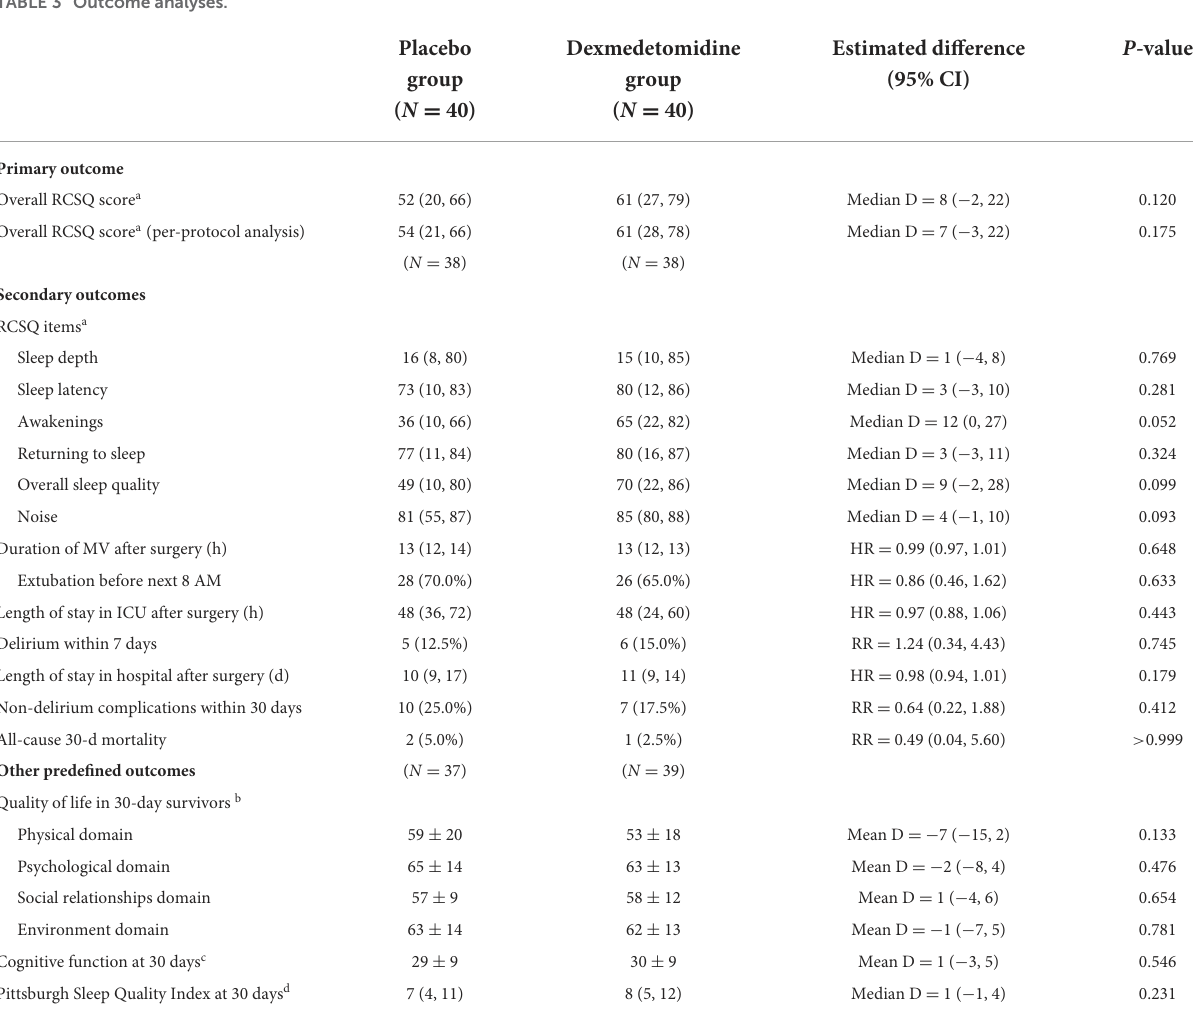
TABLE 3 Outcome analyses.